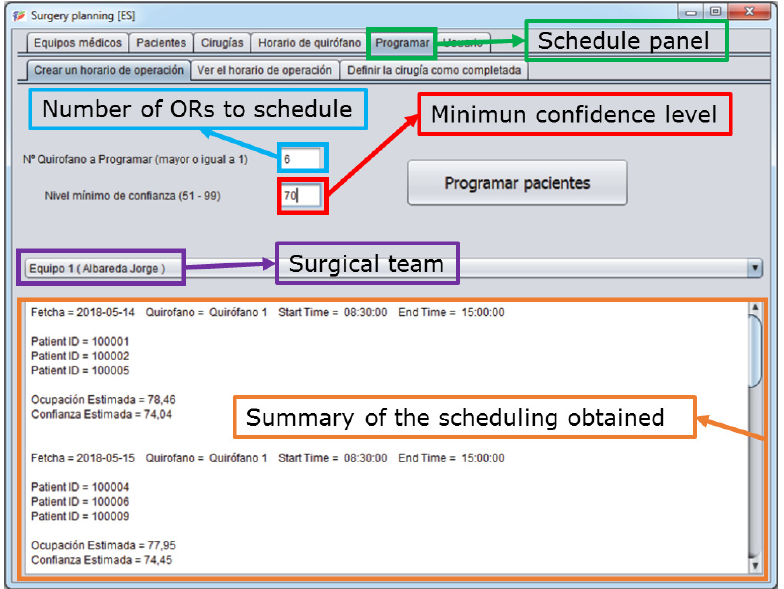
Scheduling panel. The main interface of the software tool is shown. Particularly, the scheduling panel where once the number of blocks to schedule, the minimum confidence level, and the surgical team are introduced, a summary of the scheduling performed is shown at the bottom